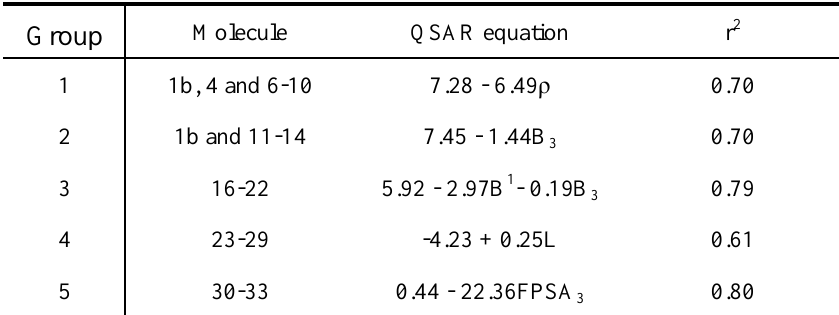
Table 5. QSAR equations for